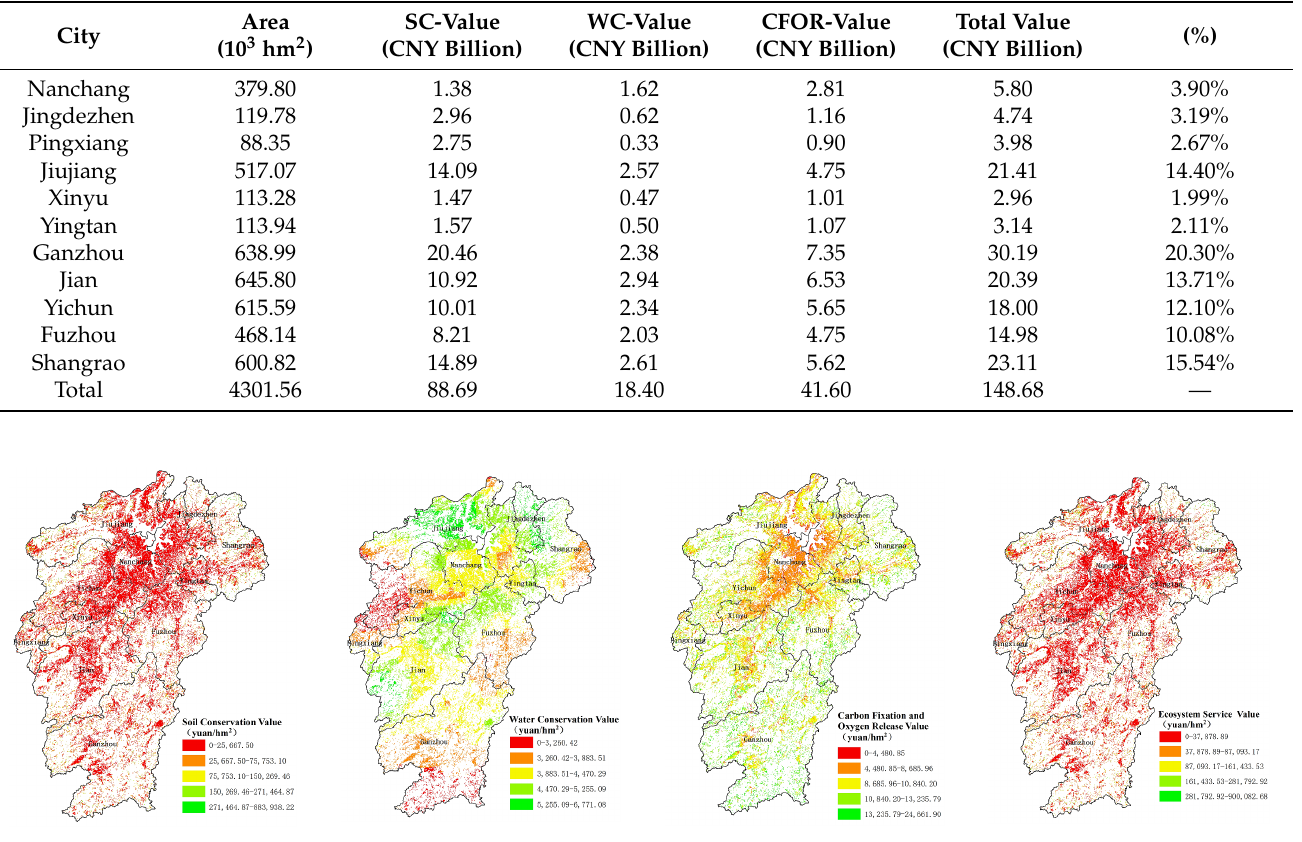
Figure 2. Spatial distribution map of total value of cultivated land resource asset ecosystem service function. 3.2. The Results of Ecological Footprint and Ecological Carrying Capacity for Cultivated Land Calculating the ecological profit and loss of cultivated land in cities of Jiangxi prov- ince can effectively identify the ecological surplus and deficit of cultivated land according to Formula (15). Nanchang, Pingxiang and Jiujiang were the cultivated land ecological deficit areas in 2018, since the population density and industrial economic development of the three cities was in the forefront in all cities in Jiangxi, located in Poyang Lake Eco- nomic Belt. However, these cities were also subject to lower payment of horizontal eco- logical compensation for cultivated land in Jiangxi due to weak grain production capacity. By contrast, eight cities including Jingdezhen, Xinyu, Yingtan, Ganzhou, Ji’an, Yichun, Fuzhou and Shangrao, are arable land ecological surplus regions, which have larger ara- ble land areas and favorable conditions for agricultural cultivation. Moreover, the three cities with the highest ecological surplus areas were Yichun, Jian and Fuzhou, and the ecological surplus areas of these cities is 853.3 thousand hm 2 , up to about 67.78% ecologi- cal surplus area of all cities in Jiangxi, as shown in Table 3 and Figure 3. Table 3. Ecological surplus of cultivated land resource assets in various cities of Jiangxi province. City